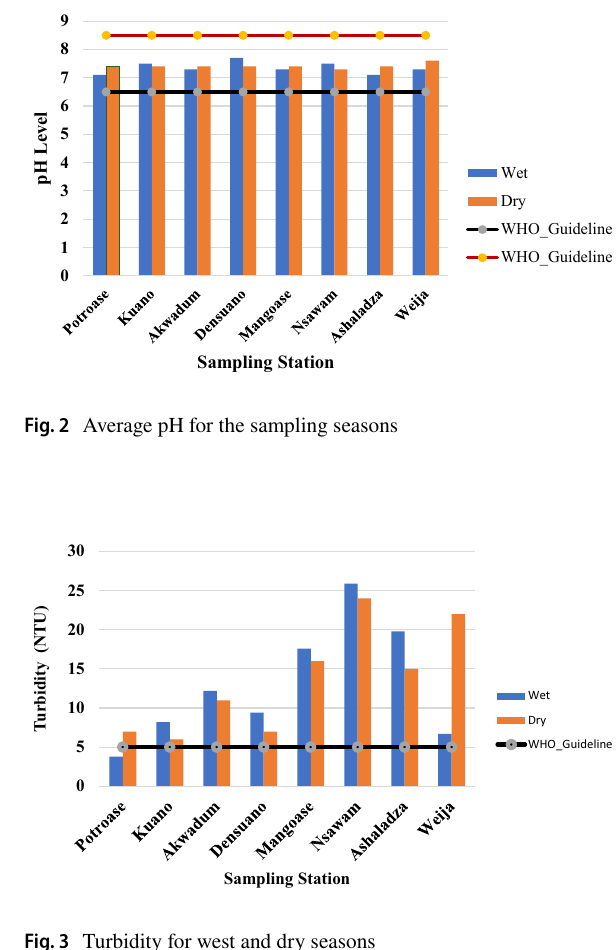
Fig. 3 Turbidity for west and dry